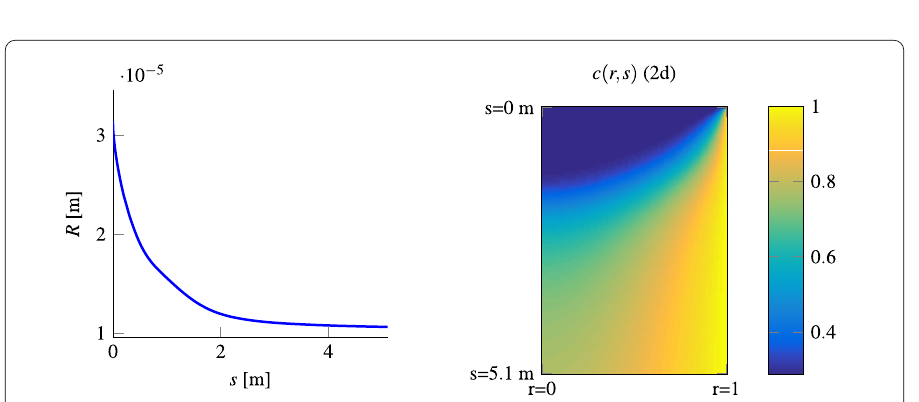
Figure 3 Left: Resulting fiber radius R for the solution quantities in Fig. 2. Right: Polymer mass fraction of fiber solution (cf. Figs. 1 and 2)